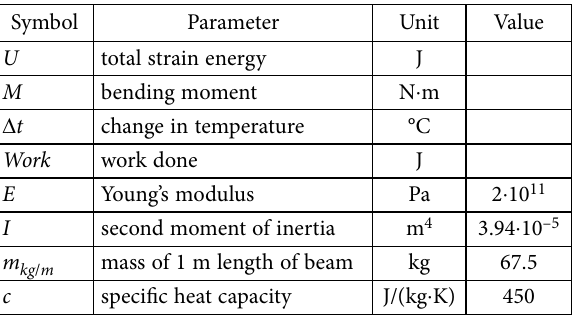
Figure 8. Vertical bending block diagram Table 3. Additional simply supported beam parameters, symbols and